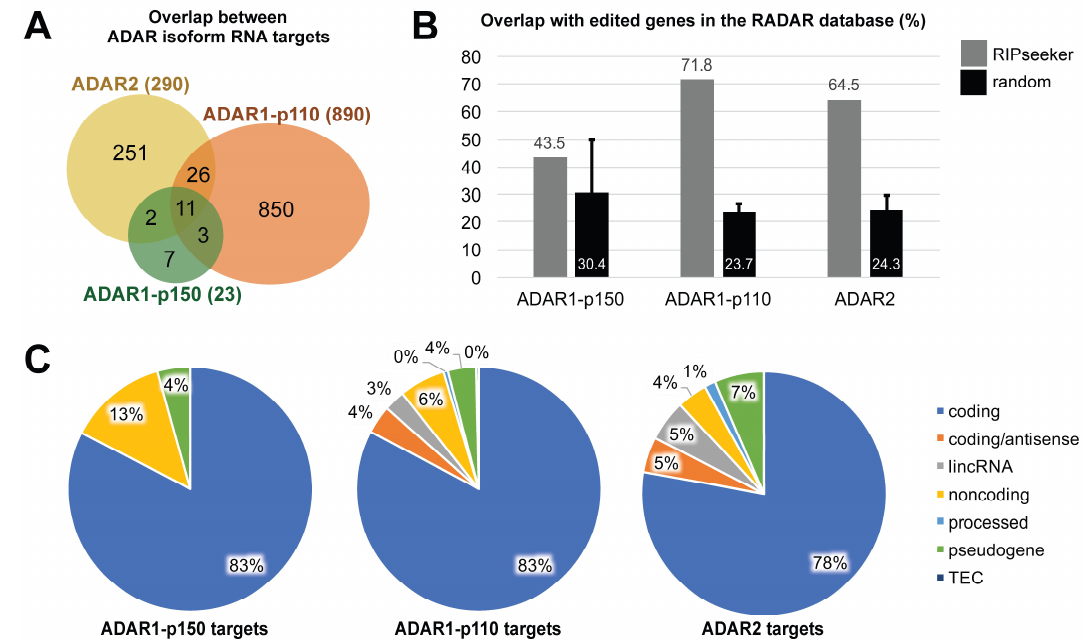
Figure 3. Identification of ADAR isoform-specific binding targets by RIPSeeker. ( A ) Venn diagram showing the overlap between the unique gene IDs of ADAR1-p150-, ADAR1-p110- and ADAR2-bound transcripts. ( B ) Overlap between unique gene IDs for each ADAR and unique gene IDs registered in the RADAR A-to-I editing site database (grey), compared to the mean overlap of 10,000 datasets chosen randomly from the human gene annotation file. Each random data set was similar in size to the corresponding ADAR; and ( C ) pie charts representing the proportion of RNA categories found in each ADAR-bound sample, respectively. Blue: coding transcripts; other colors: non-coding or uncharacterized transcripts.